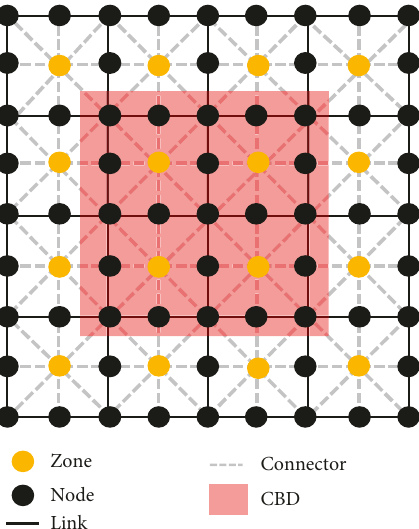
Figure 6: Illustration of the local search process.